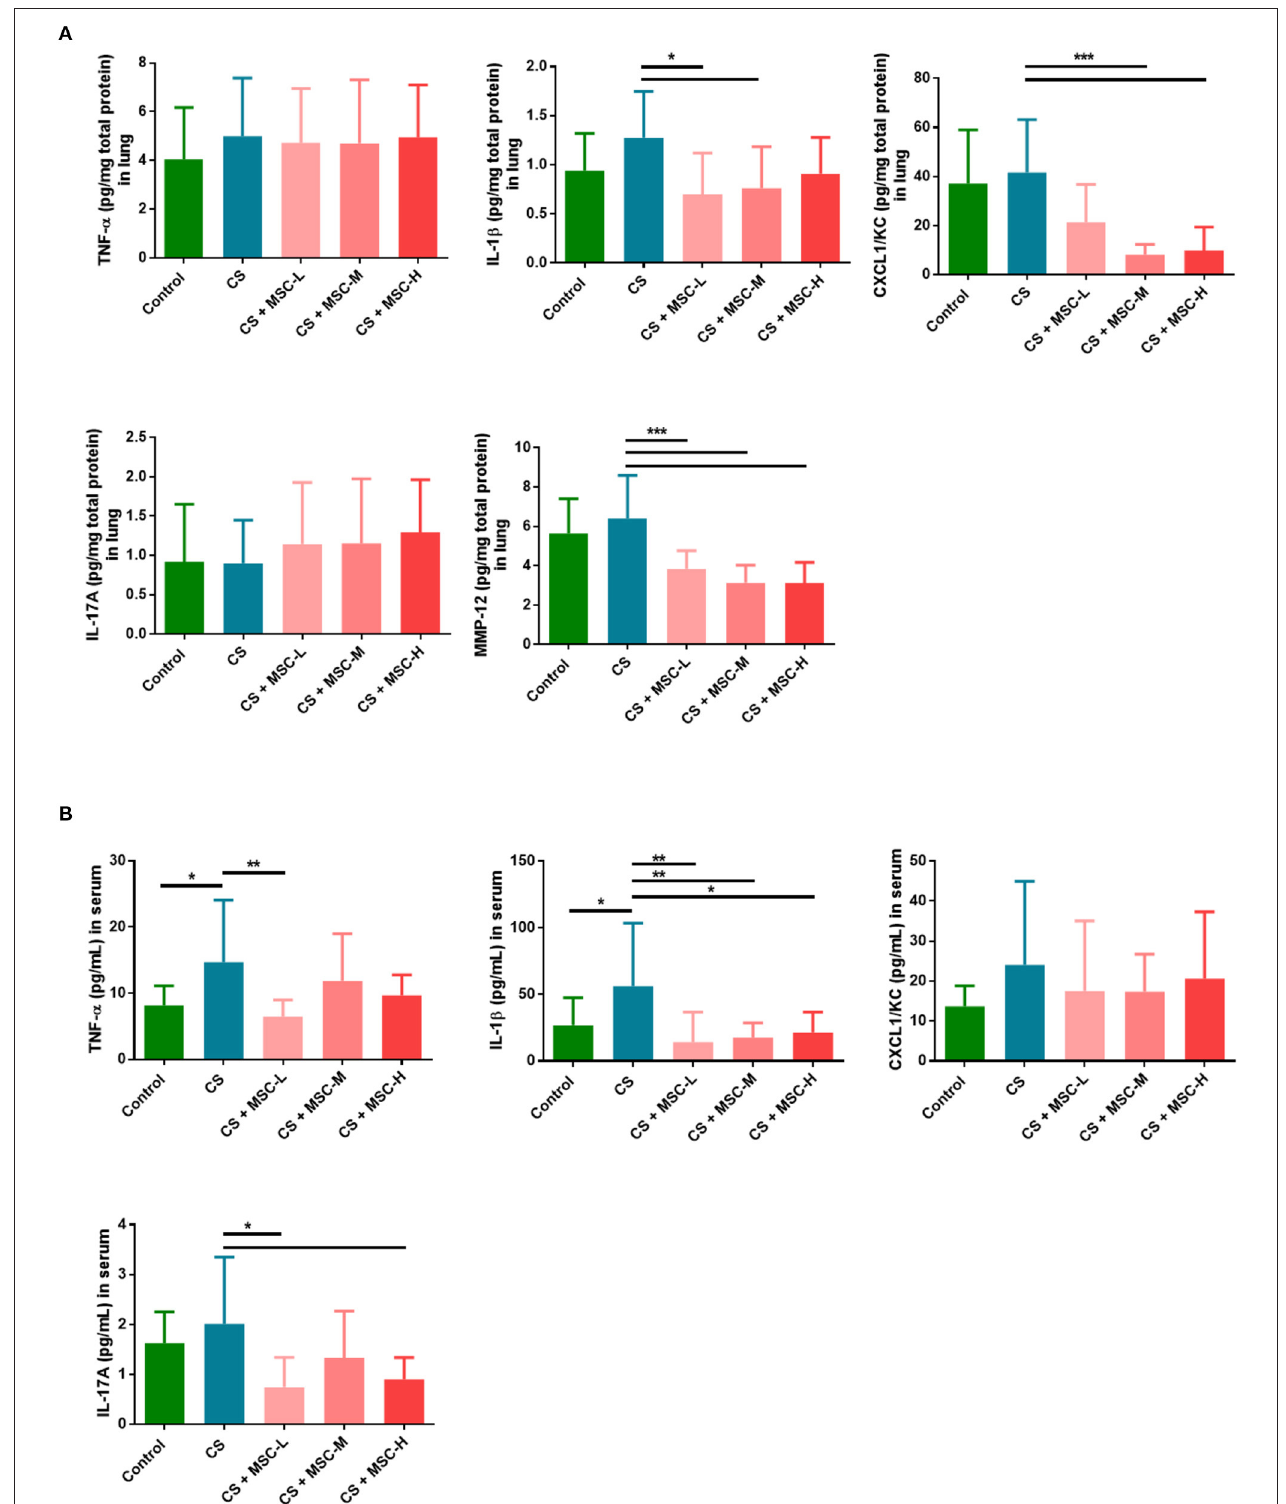
FIGURE 4 | (A) Human umbilical cord-derived mesenchymal stem cells (hUC-MSCs) downregulated interleukin (IL)-1 β , C-X-C chemokine ligand 1 (CXCL1)/ keratinocyte chemoattractant (KC), and matrix metalloproteinase (MMP)-12 in lung lysates. (B) hUC-MSCs decreased systemic cytokine production